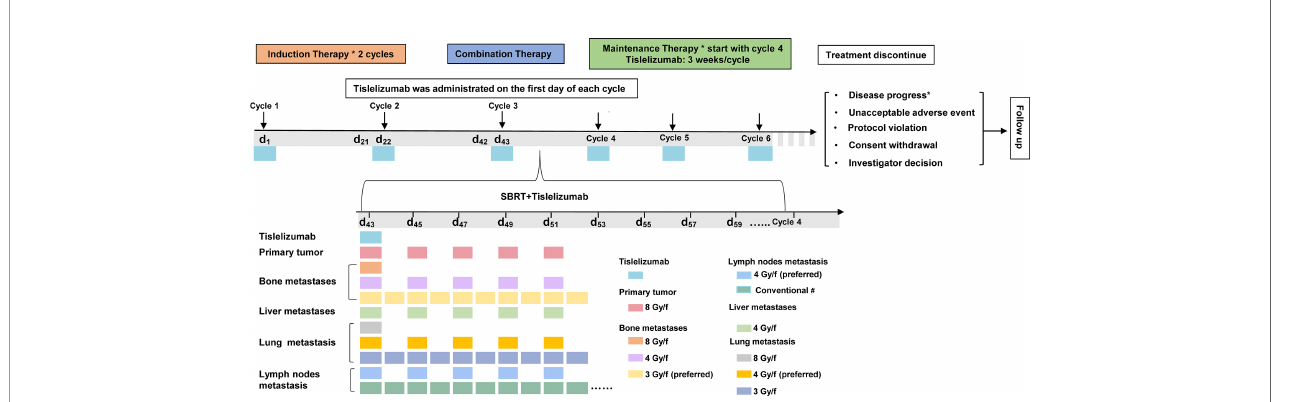
FIGURE 2 | Flowchart of the treatment protocol. The therapeutic scheme has been divided into four phases: Induction phase, where patients were scheduled to receive the tislelizumab every 3 weeks (21-day cycle) for two cycles; Combination phase, where patients were scheduled to receive the SBRT (once every 2 days during one cycle) combined with tislelizumab (on day 1 every cycle); and Consolidation and maintenance phases, at 14 days after completing synchronous radiation, where patients were scheduled to receive tislelizumab alone on day 1 of a 21-day cycle until treatment was discontinued. During the follow-up, observing this study ’ s safety and clinical ef fi cacy were observed. Abbreviations: PD-1, programmed cell death-1; SBRT, stereotactic body radiation therapy. The asterisk indicates that disease progression was con fi rmed according to the modi fi ed RECIST 1.1 of PCWG3. The number sign indicates that patients would receive conventional radiotherapy with 2 Gy every day up to a total dose of 40 or 50 Gy if the surrounding critical organs were at risk around lymph nodes, such as the duodenum, small intestine, and